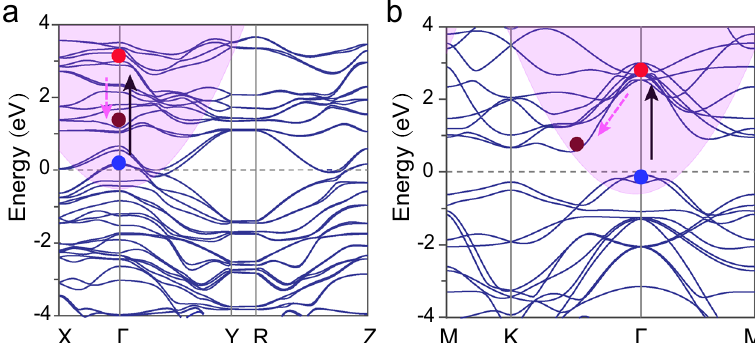
Fig. 5 Schematic of photoexcited carrier dynamics. The calculated band structures of bilayer 1T ′ -MoTe 2 in a and 2H-MoTe 2 in b . The purple shaded areas show the band structurse that are accessible by the 4.54eV photoionization probe. The top red and brown circles indicate the electrons, and the bottom blue circles indicate the holes. The black arrows indicate the 3.02eV photoexcitation. The magenta dashed arrows stand for the electrons ’ relaxation